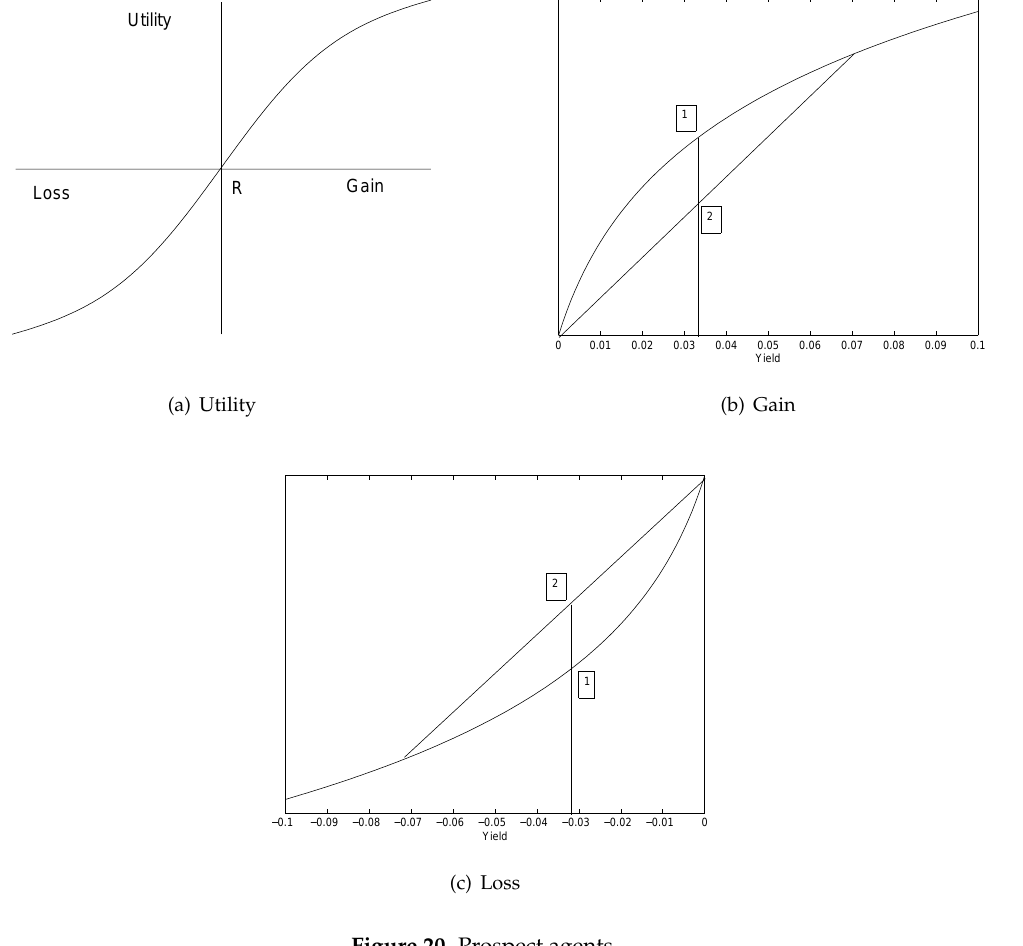
Figure 20. Prospect